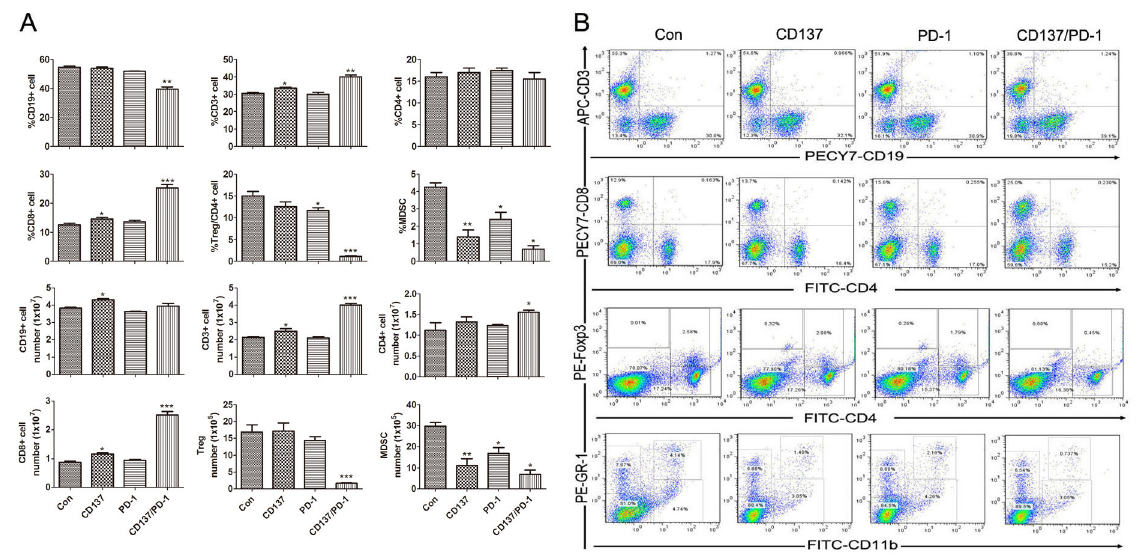
Figure 2. Analysis of lymphocyte components in spleens from mice treated with mAb combinations. Mice (3/group) transplanted i.p. with 3 × 10 6 ID8 cells 10 days earlier were injected i.p. with 0.5 mg of control, anti-CD137, anti-PD-1 or anti-PD-1/ CD137 mAb and the mAb injection was repeated 4 days later. Seven days after the second injection, spleens were harvested and single cell suspensions prepared and stained with fluorescence labeled antibodies against markers of lymphocyte subsets prior to analysis by flow cytometry. The percentages and numbers of CD3 + , CD4 + , CD8 + , CD19 + , FoxP3 + /CD4 and GR-1 + CD11b + cells in spleens are shown in (A) and representative dotplots are shown in (B). Data are presented as M ±SEM from 3 mice/group and are representative of 3 independent experiments. *P < 0.05, **P < 0.01, ***P < 0.001, The findings with anti- PD-1 or CD137 single mAbs are compared with control mAb, and the findings with anti- PD-1/CD137 mAbs are compared with both control and single